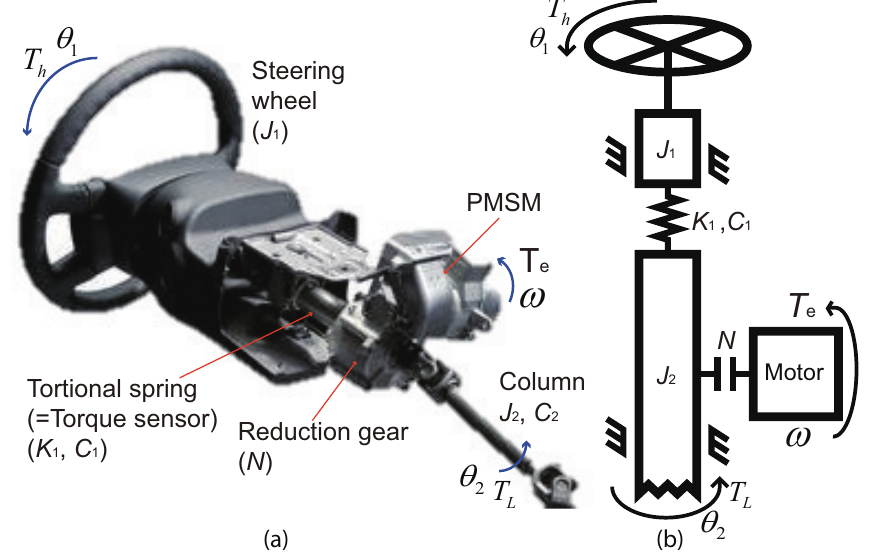
Figure 1. The picture and the schematic of the electric power steering (EPS) system. PMSM: permanent magnet synchronous